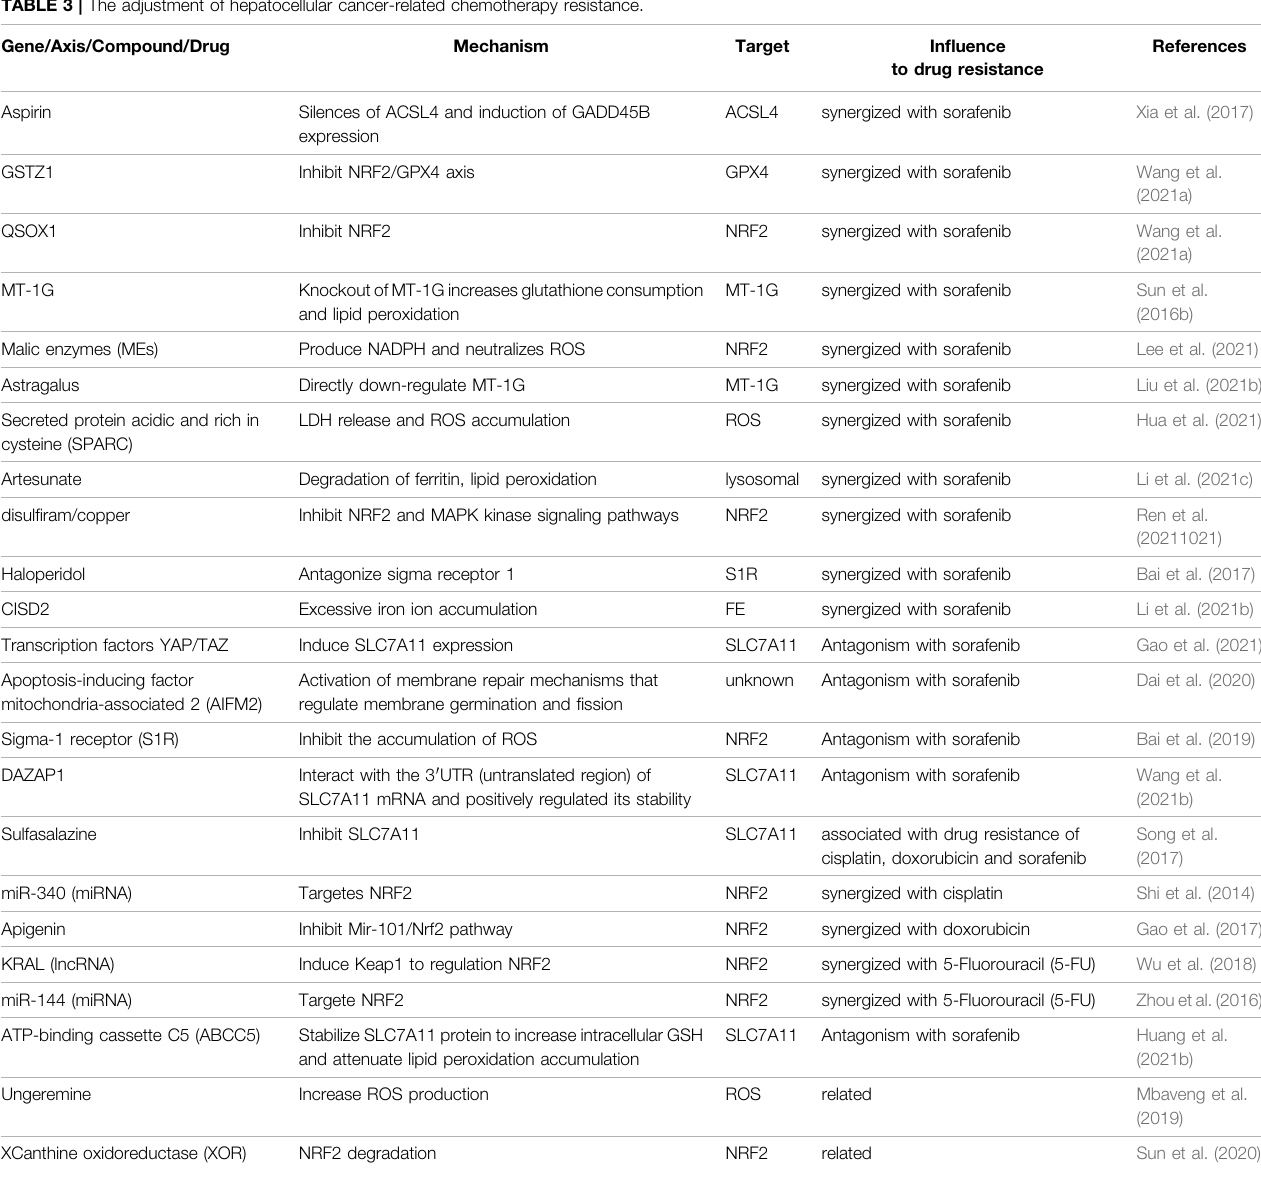
TABLE 3 | The adjustment of hepatocellular cancer-related chemotherapy